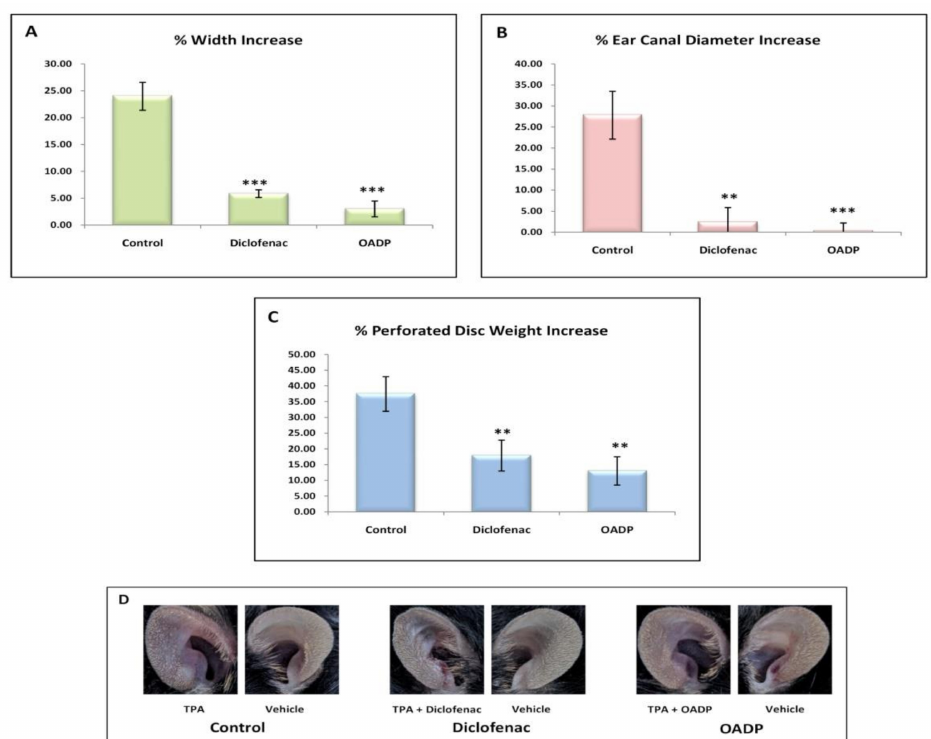
Figure 8. Increases in the percentage of the different morphological parameters: Width ( A ), diameter of the external auditory canal ( B ), and weight of the 6mm disc practiced ( C ). These increases have been calculated from the differences between the left and right ears in the different groups of mice (Control, Diclofenac, OADP) ( D ). The mean ± S.E.M. is shown for each of these parameters ( n =